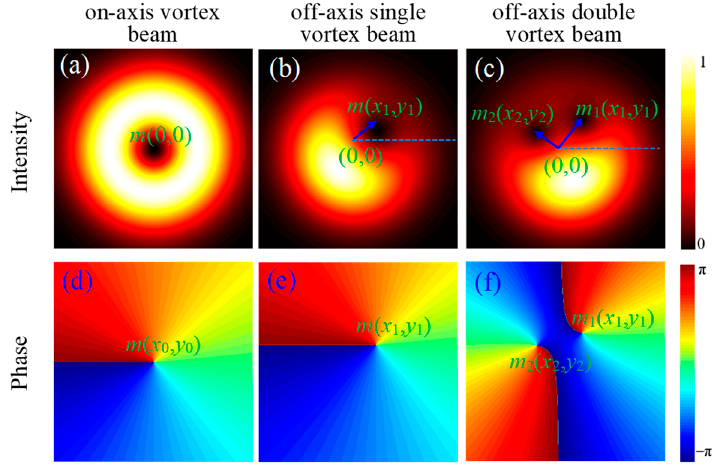
Figure 1. ( a – f ) The intensity and phase distributions of the on-axis vortex, off-axis single vortex, and off-axis double vortex beams. The parameters describing the vortex beams are marked in the figures.